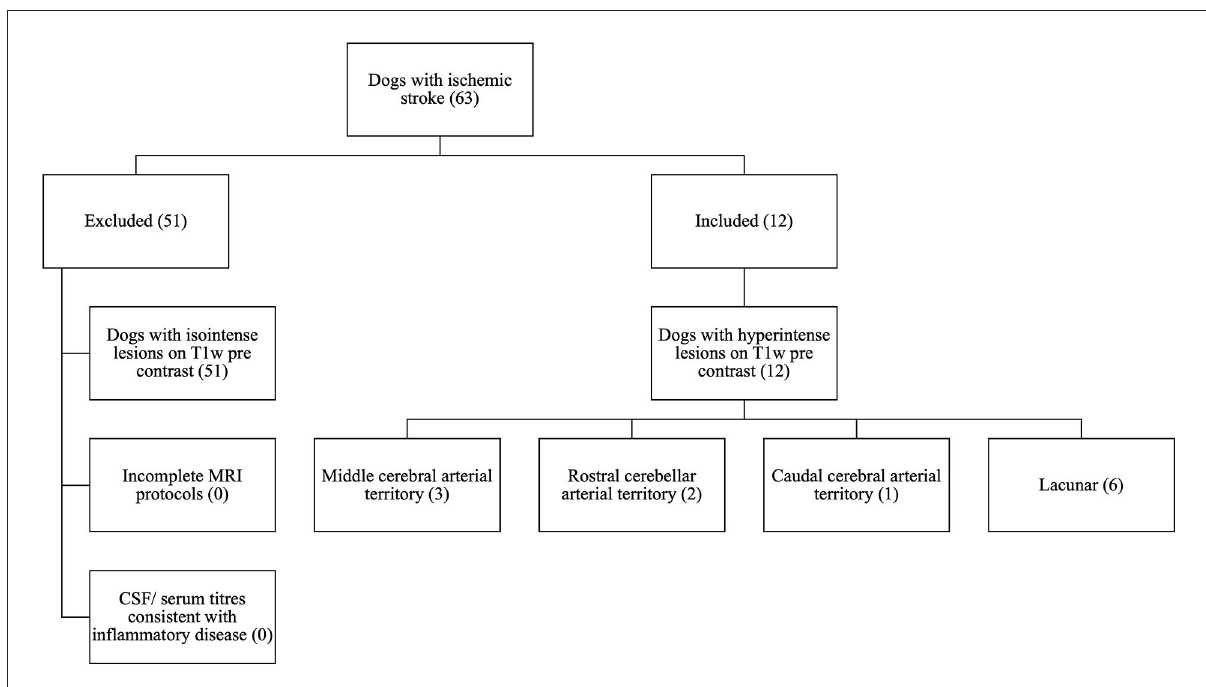
FIGURE1 CONSORT diagram to demonstrate the selection process for patients with T1w pre-contrast hyperintense lesions from the initial 63 cases with ischemic stroke searched from clinical records.